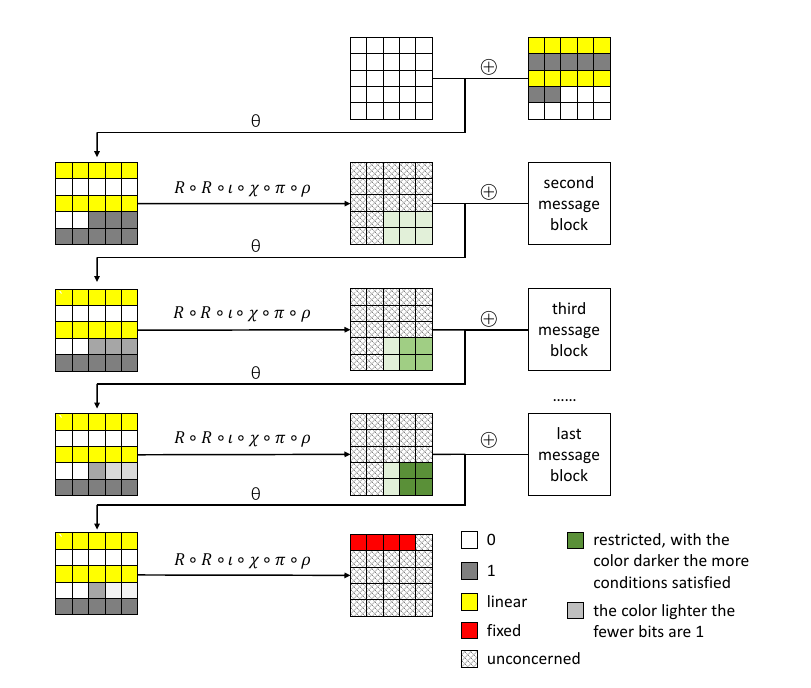
Figure 9: Iterating Strategy on 3-round Keccak-256. ( R = ι ◦ χ ◦ π ◦ ρ ◦ θ ) A possible iterating process is listed in Table 4 . Table 4: A possible iterating process of 3-round Keccak-256 via Iterating Strategy